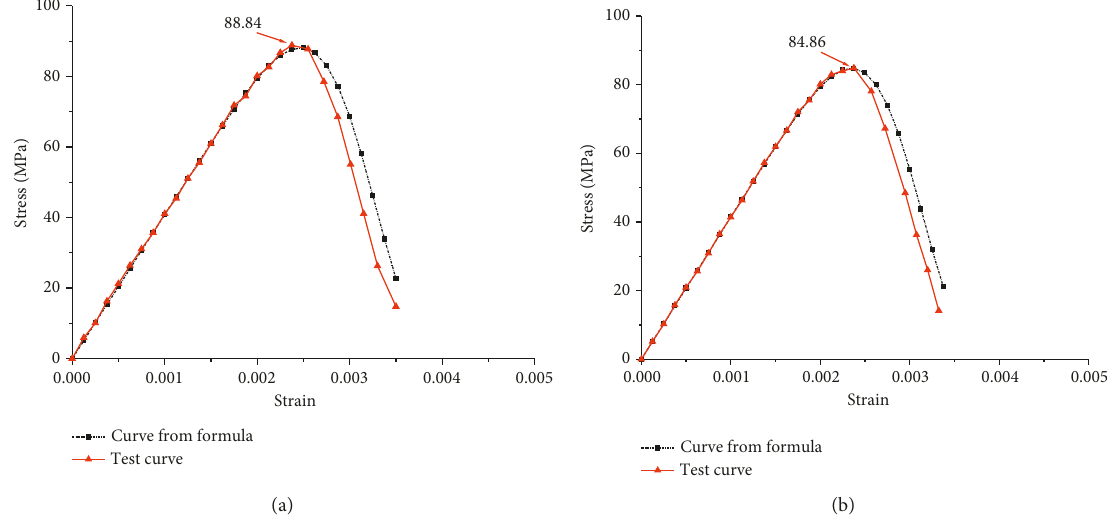
curve0.000 Curve from formula Test